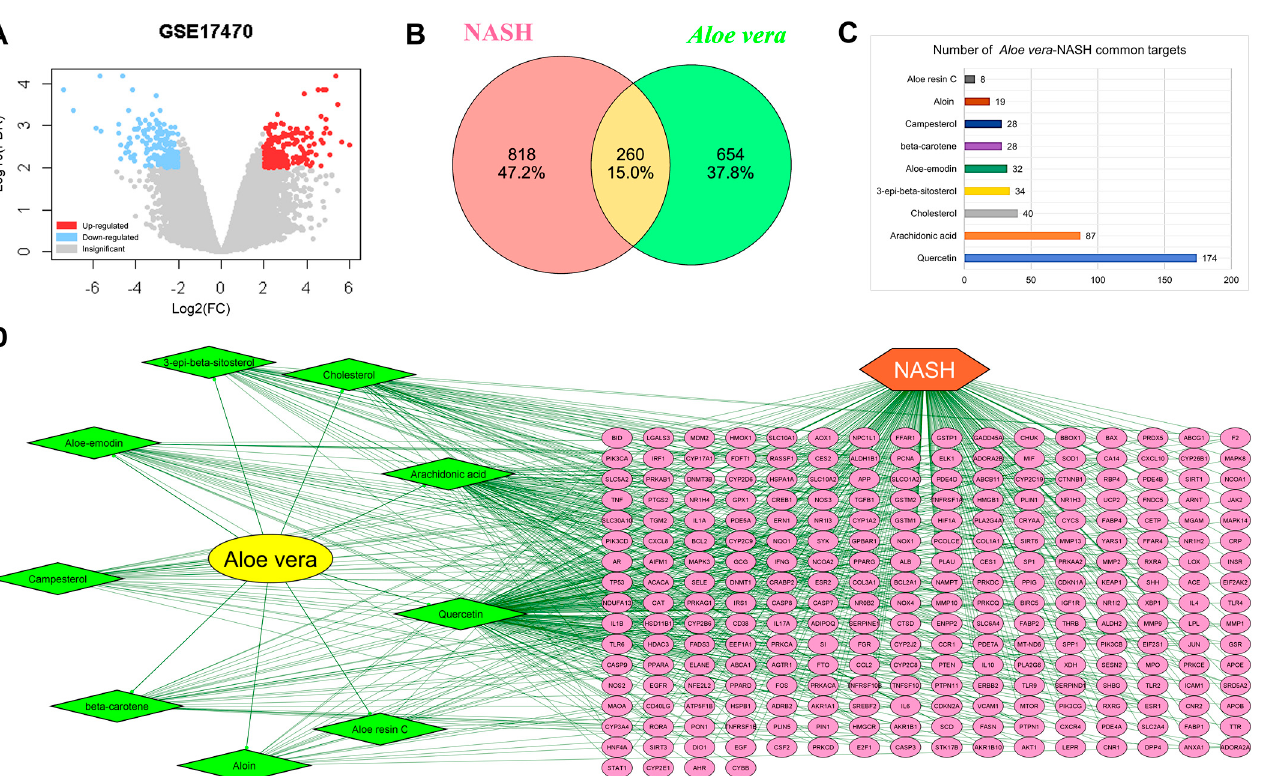
Figure 1. Common Aloe vera and non-alcoholic steatohepatitis (NASH) targets. ( A ) Volcano plot of differentially expressed genes from the GSE17470 dataset. Red and blue dots represent upregulated and downregulated genes, respectively; gray dots indicate insignificant changes. ( B ) Intersection of the Aloe vera and NASH-related targets. Red and green circles represent the predicted targets of NASH and Aloe vera , respectively. The yellow area reflects the common targets. ( C ) Number of common targets of the active ingredients. ( D ) Aloe vera and NASH herb–component–target-disease network. Green nodes display the active ingredients; pink nodes represent Aloe vera –NASH common targets, and edges reflect the interactions between nodes. FC, fold change.